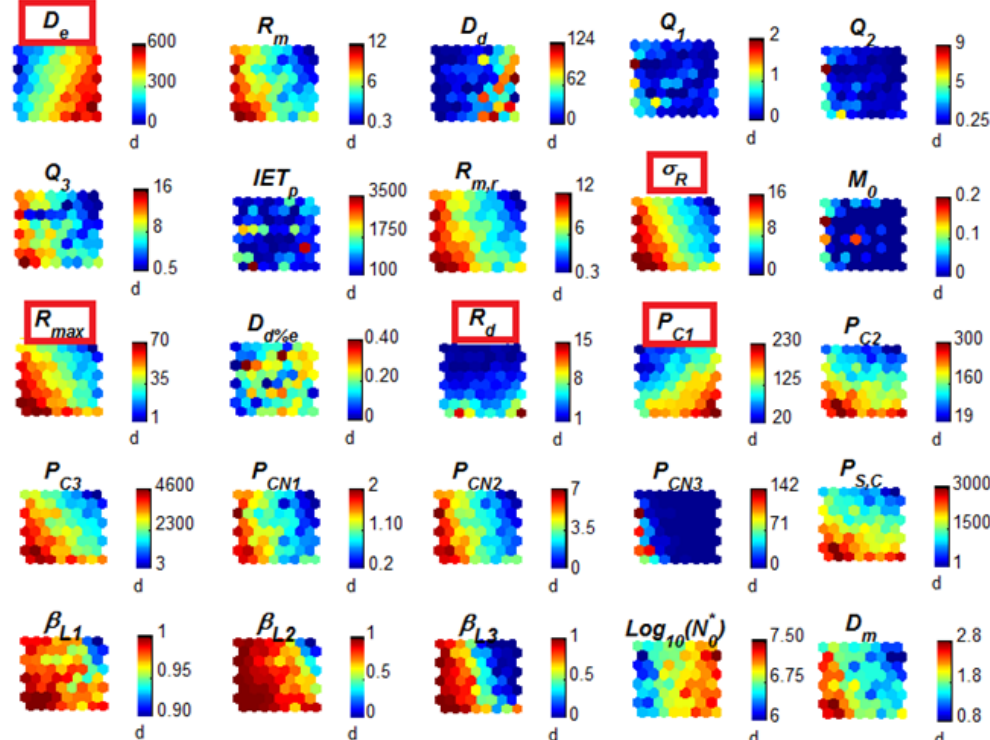
Figure 4. Projection of the M( x Best ) map according to the 23 variables. The red-framed variables are those selected by the GA algorithm. The last two variables D m and N ∗ are defined in Sect. 0